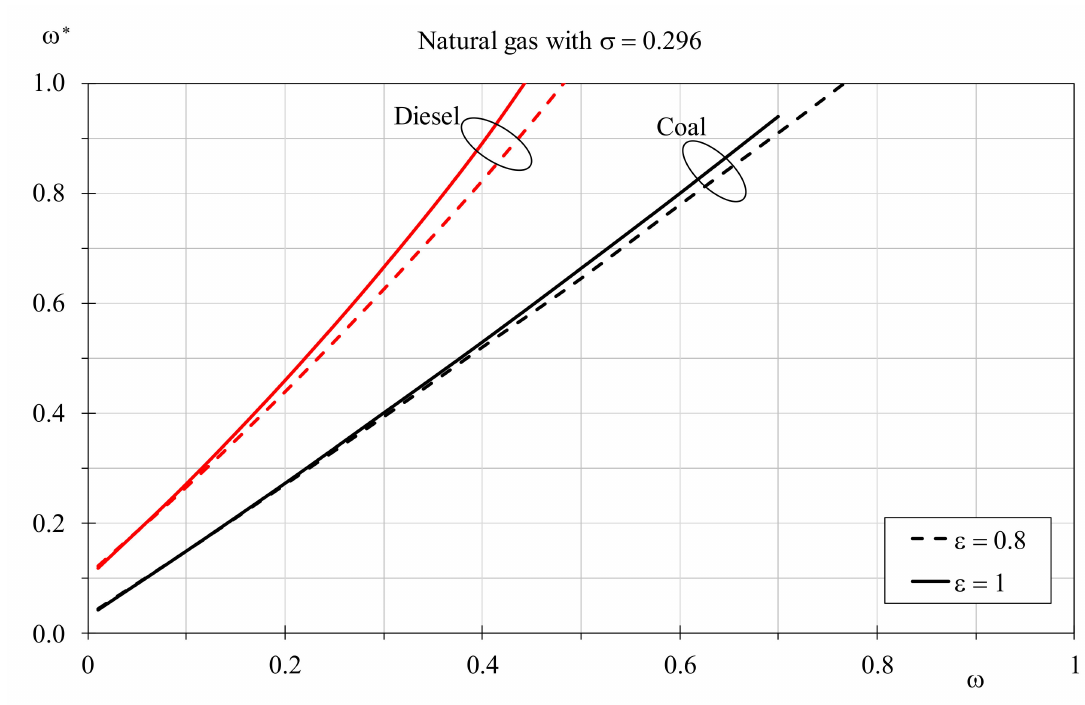
Figure 14. Required thermal capacity ratio ( ω *) to attain for diesel and coal the same EQI of natural gas that supplies boiler operating with ω and a dimensionless temperature factor of 0.296, for two different heat exchanger